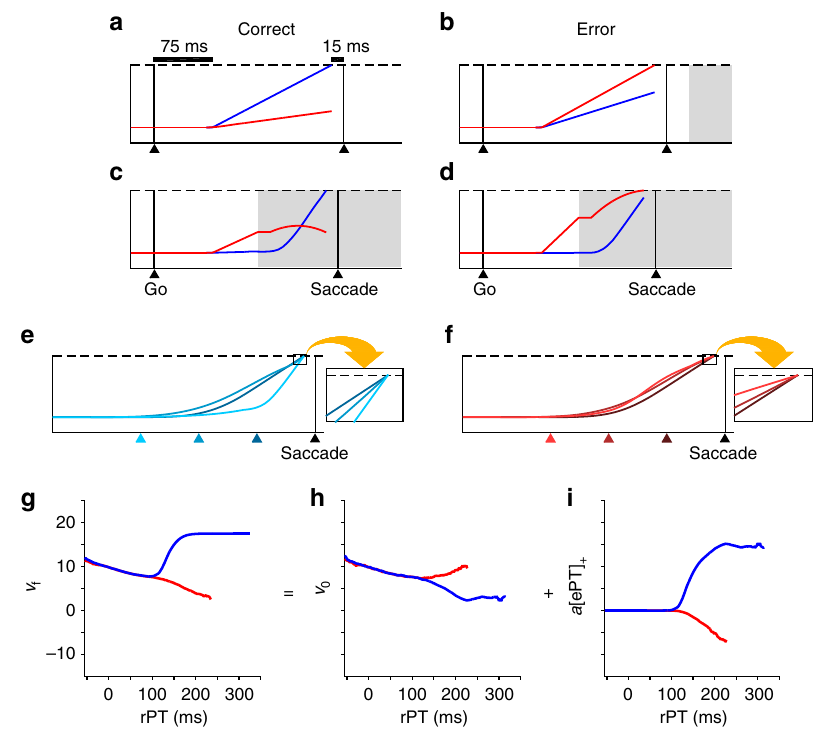
Fig. 7 The accelerated race-to-threshold model provides a plausible physiological mechanism by which sensory evidence could in fl uence saccade kinematics. a – d Four simulated trials of the accelerated race-to-threshold model. In each trial of the model, x L (red traces) and x R (blue traces) — representing the mean fi ring rates of two populations of oculomotor neurons — simultaneously rise toward a fi xed threshold (dashed lines), competing to trigger a saccade toward the left or right, respectively. For simplicity, we have illustrated only trials in which the target is on the right and the distracter on the left. Black triangles and vertical lines indicate the onset of the go (Go) and saccade (Saccade). Shaded regions represent time after cue arrival. After a short, variable afferent delay following the go signal ( fi xed here at 75 ms for illustrative purposes only), x L and x R race toward threshold with initial, constant build-up rates drawn randomly from a bivariate distribution. a A correct guess results when the variable congruent with the target ( x R ; blue trace) reaches threshold before the competing variable, and before the cue information arrives. b An incorrect guess. c , d Time permitting, the cue information accelerates the variable congruent with the target and decelerates the variable congruent with the distracter. c A correct trial in which the motor activity congruent with the target accelerates to threshold after the cue arrives. d An incorrect trial in which the variable congruent with the distracter decelerates, but still reaches threshold after the cue arrives. e , f Mean fi ring rate trajectories ( x R , x L ) that reached threshold, resulting in correct ( e ) and incorrect ( f ) outcomes at short, intermediate, and long rPTs (dark, intermediate, and light hues, respectively). Colored triangles indicate average times of cue presentation relative to saccade onset (i.e., the time from each colored triangle until saccade is equal to the mean rPT of the simulated trials in that bin). Responses are aligned on saccade onset. g – i Mean v f ( g ), v 0 ( h ), and a [ePT] + ( i ) of correct (blue) and incorrect (red) trials as functions of